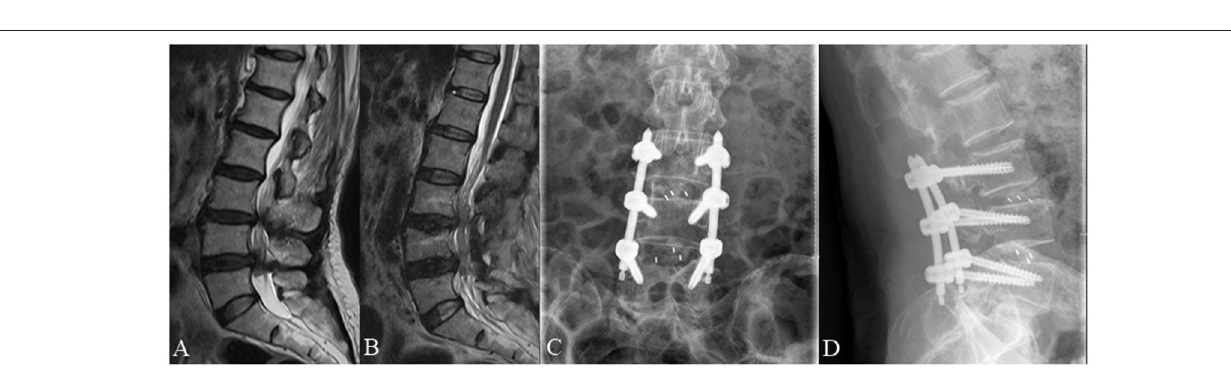
FIGURE 5 | A 70 year old female complained of low back pain and right lower extremity pain for 2 months before she underwent posterior lumbar interbody fusion at L3/4 and L4/L5. (A) Pre-operative lumbar MRI showed that the nerve roots were redundant between the L3/4 and L4/L5 intervertebral disc. (B) Post-operative MRI obtained 3 days after surgery showed significant improvement with resolution of RNRs. (C,D) Lumbar radiographs obtained 3 months after surgery demonstrate internal fixation in good position without cage subsidence or